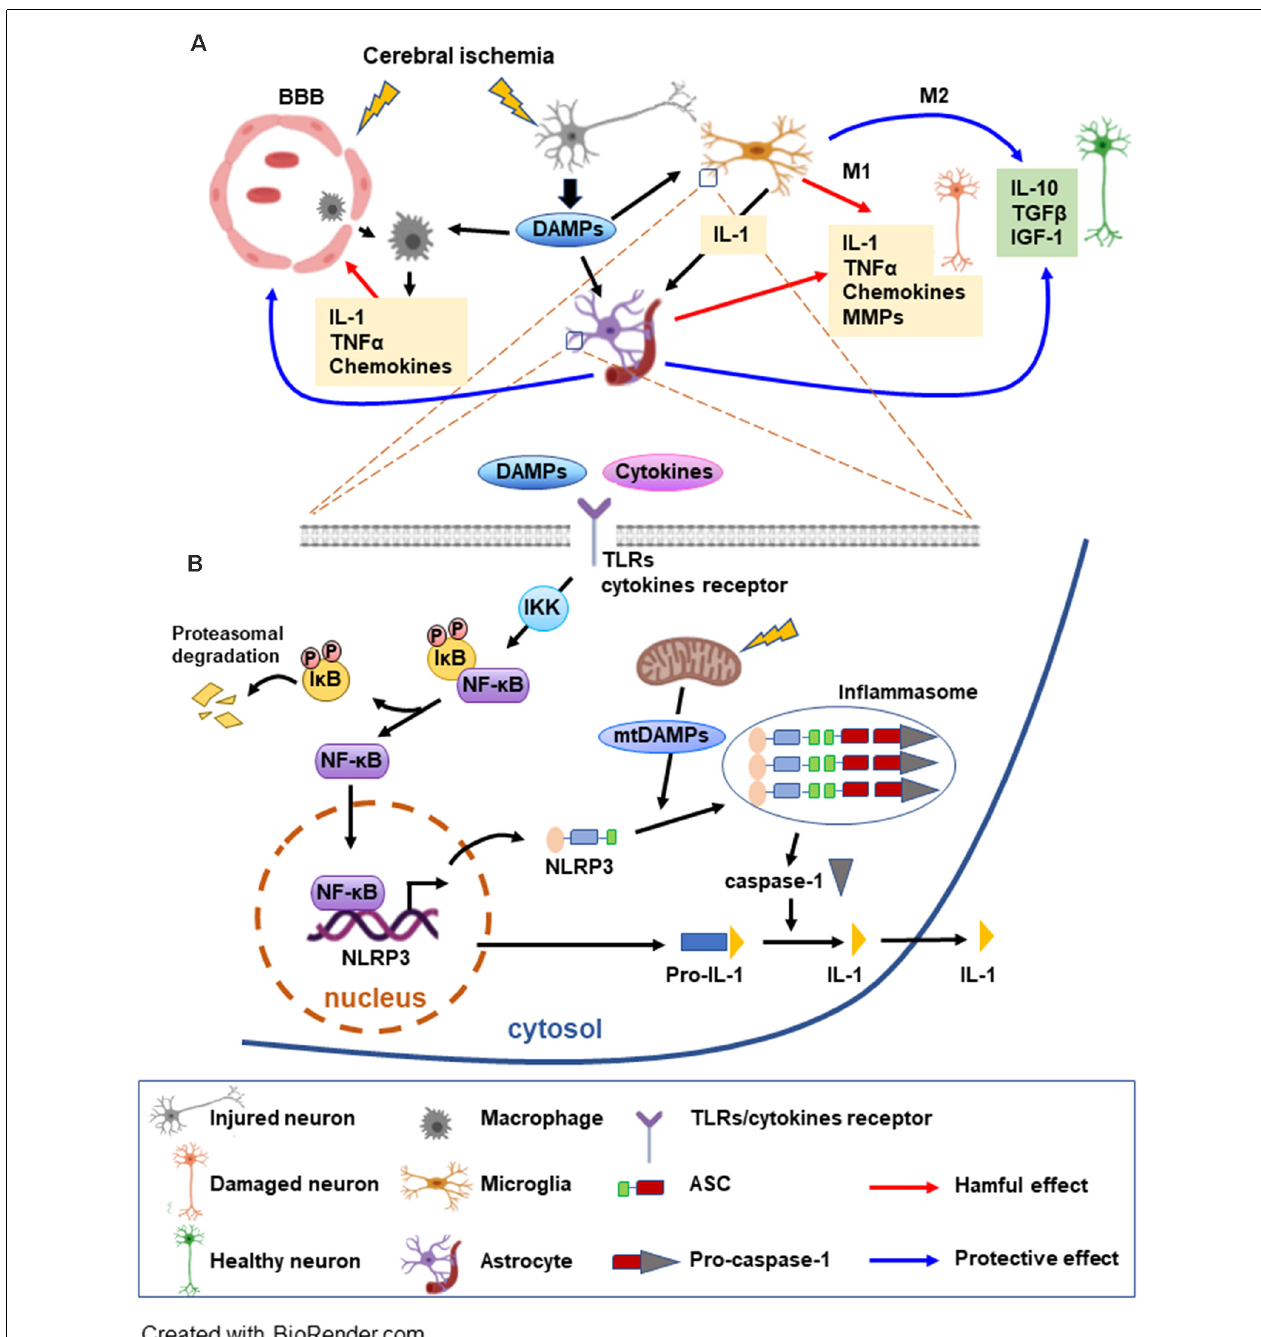
FIGURE 1 | Schematic overview of the postischemic inflammatory response and NF- κ B signaling pathways mediating NLRP3 inflammasome activation. (A) Cerebral ischemia triggers the disruption of the blood brain barrier (BBB) allowing for the macrophages to migrate to the ischemic area. Injured neurons release DAMPs soon after the onset of ischemia, which can be detected by microglia, astrocytes, and macrophages initiating an inflammatory response. The inflammatory molecules released by the glia have deleterious as well beneficial effects on neurons. M1 microglia generate interleukin (IL)-1 β and tumor necrosis factor (TNF) which further induce cytokine and chemokine release from astrocytes. M1 microglia also release MMPs, enhancing BBB disruption and worsening brain damage. A beneficial role of glia consists of producing anti-inflammatory cytokines and trophic molecules. Additionally, astrocytes can be involved in the repair of the BBB. (B) DAMPs and cytokines trigger TLR/cytokine receptor signaling, leading to NF- κ B activation. NF- κ B, a major factor in the inflammasome priming phase, is activated upon phosphorylation of the inhibitor I κ B by IKK. NF- κ B can then translocate to the nucleus to induce transcription of the inflammasome complex elements. DAMPs released by mitochondria (mtDAMPs) constitute the signal that triggers the assembly and activation of the inflammasome. Caspase-1 is activated by the inflammasome and can transform the inactive pro-IL-1 into active IL-1 which can be released (see text for abbreviations).